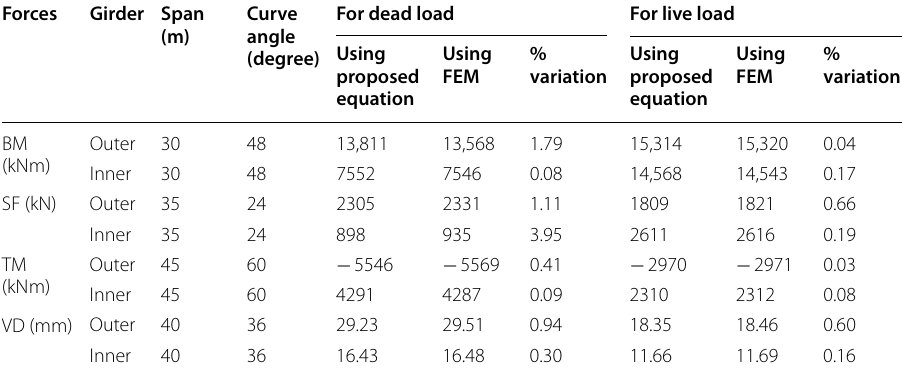
Using % FEM variation